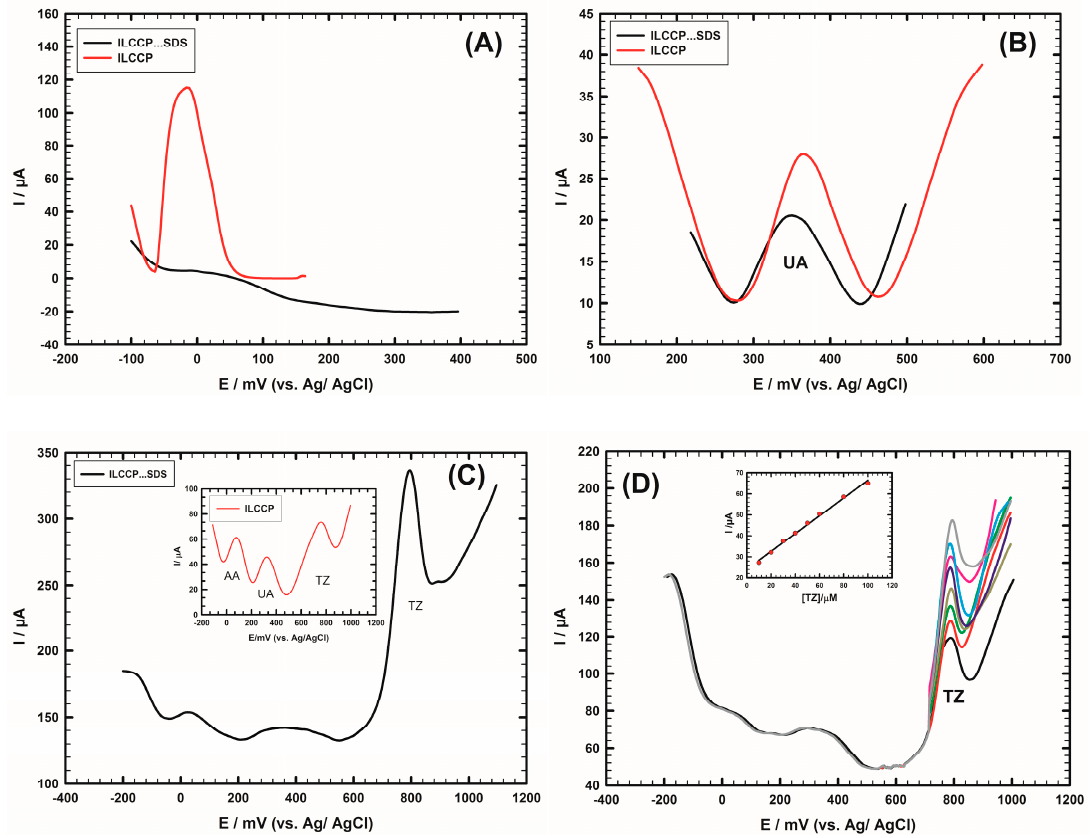
Figure 9. ( A ) DPV of 0.1 mmol · L − 1 AA at ILCCPE and ILCCPE. . . SDS; ( B ) DPV of 0.01 mmol · L − 1 UA at ILCCPE and ILCCE. . . SDS; ( C ) DPV of 0.1 mmol · L − 1 TZ in presence of 0.01 mmol · L − 1 UA and 0.1 mmol · L − 1 AA at ILCCPE. . . SDS (inset: DPV of 0.1 mmol · L − 1 TZ in presence of 0.01 mmol · L − 1 UA and 0.1 mmol · L − 1 AA at ILCCPE); and ( D ) DPVs of TZ in presence of 0.01 mmol · L − 1 UA and 0.1 mmol · L − 1 AA at ILCCPE. . . SDS for concentration range (10 µ mol · L − 1 –100 µ mol · L − 1 ) (inset: calibration curve for TZ in the linear range (10 µ mol · L − 1 –100 µ mol · L − 1 ) at ILCCPE. . .